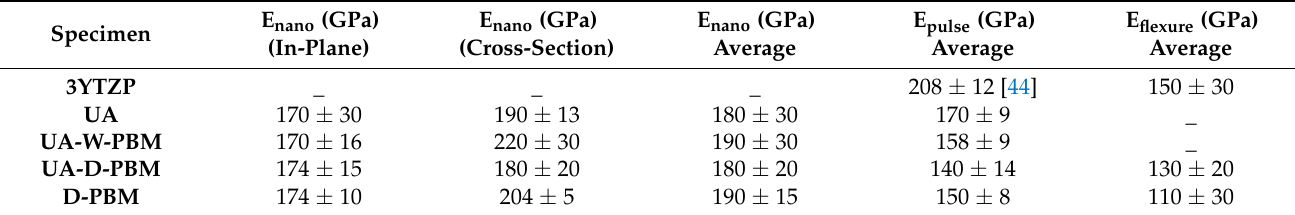
Table 3. Young’s modulus from nano-indentation experiments (E nano ), macroscopical results of the Young’s modulus from impulse- echo technique (E pulse ) and flexure modulus from bending (E flexure ) tests. Some values for the reference monolithic 3 mol % yttria tetragonal zirconia (3YTZP) are also